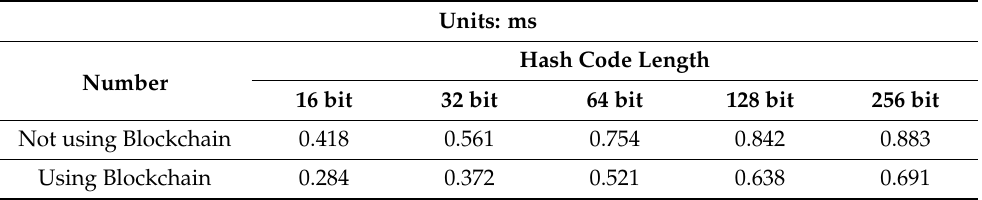
Table 4. Storage rate according to hash code length of IoT data block.